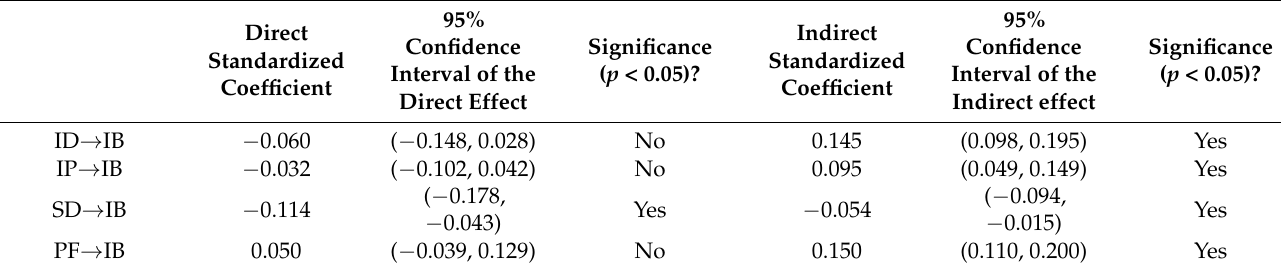
Table 6. Significance analysis of direct and indirect